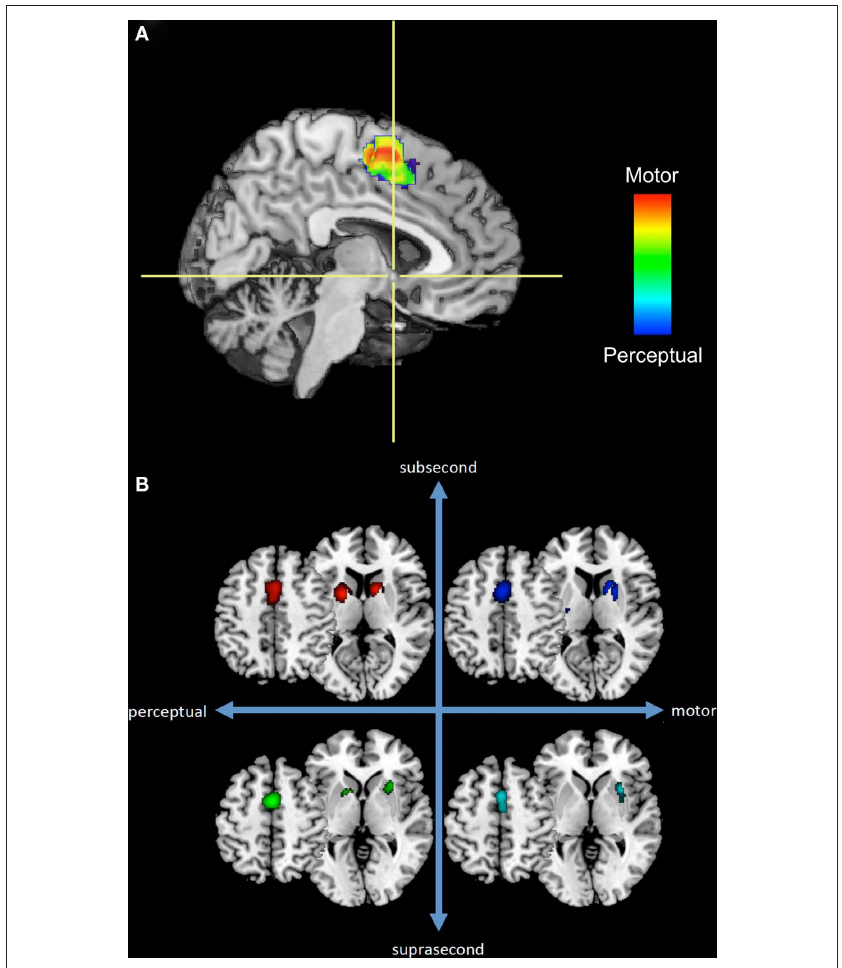
FIgure 1 | A subset of the results from our previous meta-analysis of neuroimaging timing studies. (A) Sagittal section of a rendered brain including SMA voxels from perceptual or motor timing tasks (regardless of duration length) and their overlap. Crosshairs are located at the anterior commissure with the vertical axis dividing the SMA and pre-SMA. (B) Separate ALE results for SMA and basal ganglia regions across four temporal